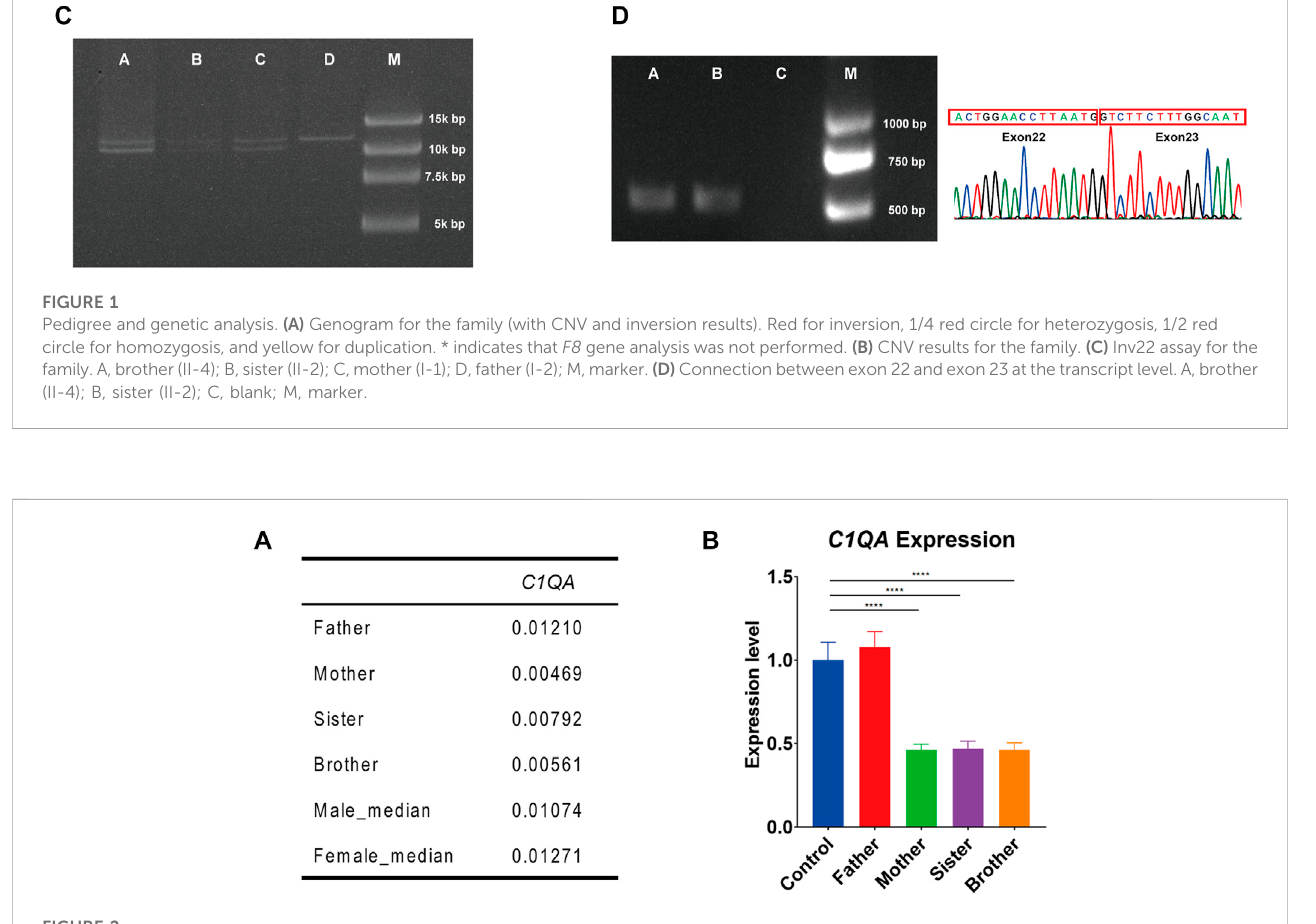
FIGURE 2 C1QA expressioninthefamilymembers. (A) C1QA expressionlevelsinfourfamilymembersandreferencedatabases(male_medianandfemale_median) by RNA-seq analysis (values represented the relative expression to GAPDH ). (B) . Q-PCR con fi rmation of C1QA expression in four family members and normal control (one-way ANOVA and Dunnett ’ s multiple comparison test; ****, p <